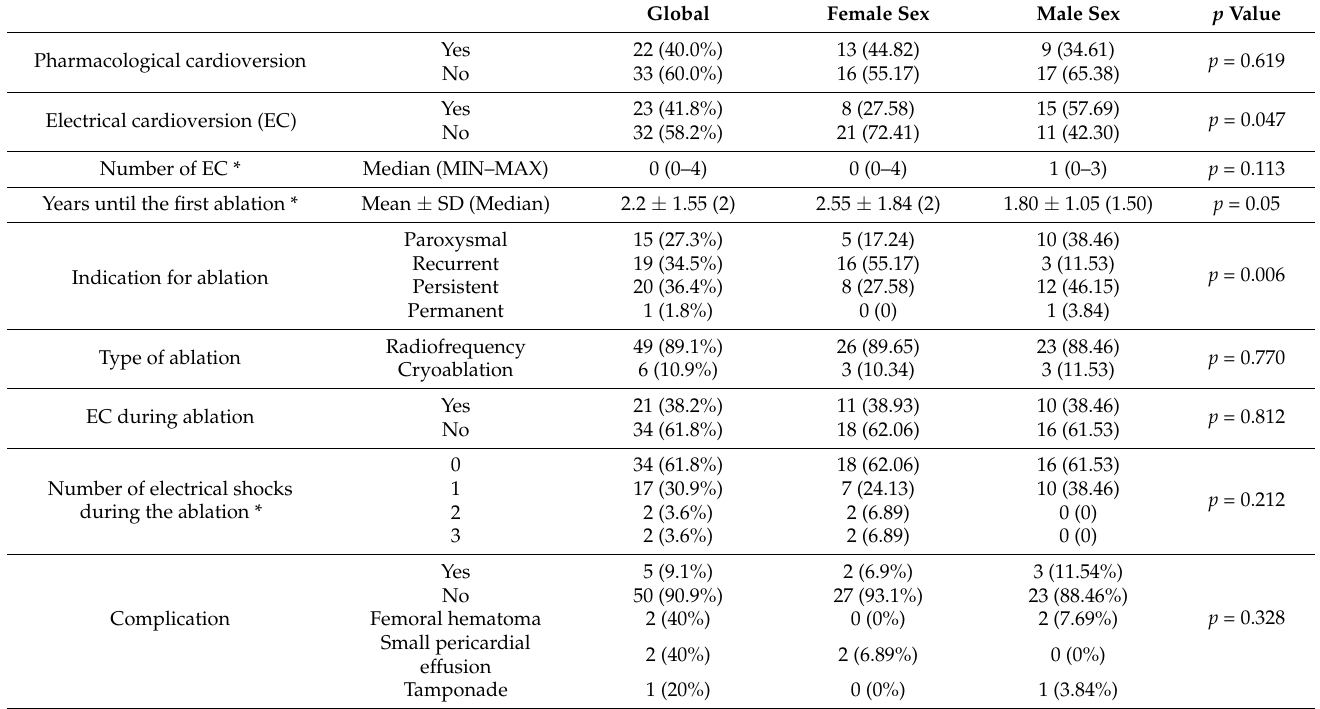
Table 5. Treatment aspects for cardiac rhythm control: electrical cardioversion and catheter